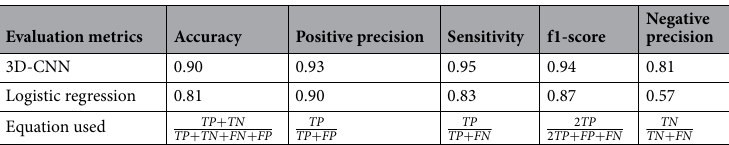
Table 2. Derivations of the confusion matrix. TN true negative, FP false positive , FN false negative , TP true